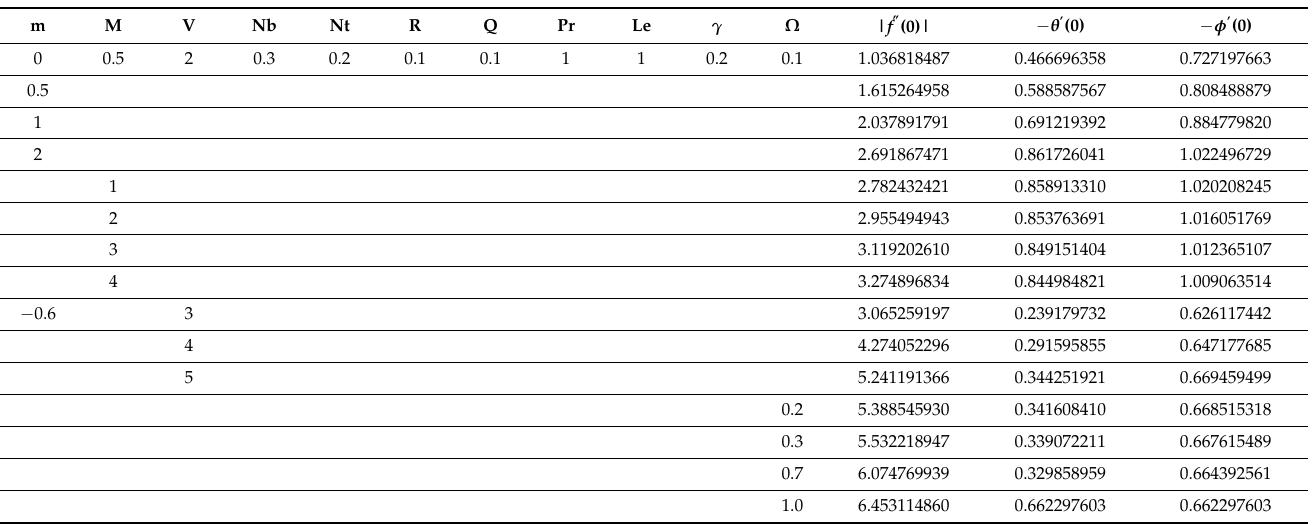
Table 4. Skin friction coefficients, local Nusselt numbers and local Sherwood numbers for various values of parameters involved using